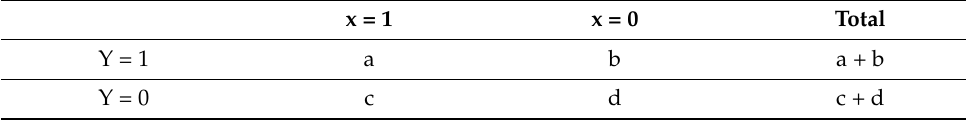
Table 2. Two groups of classification variable values definition